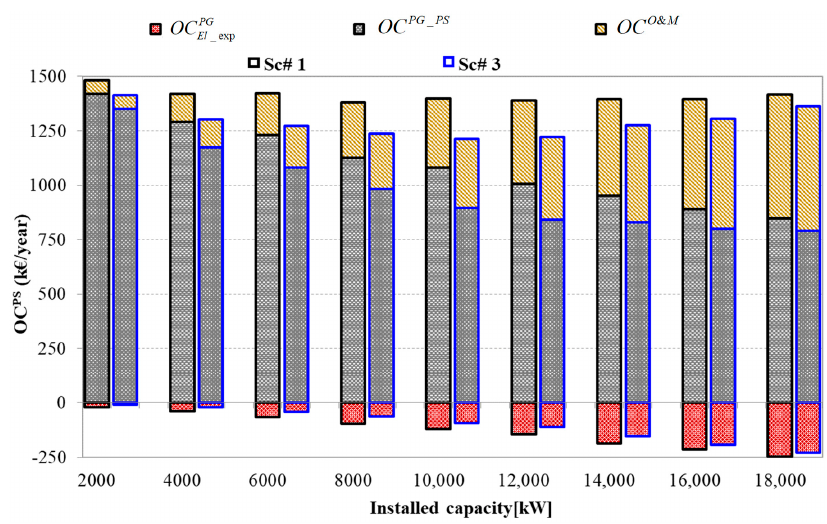
Figure 8. Operating costs of PS as a function of installed PV capacity.